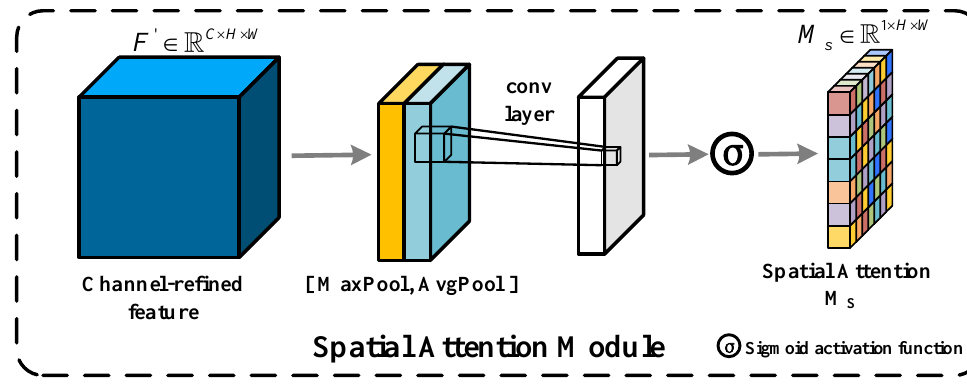
Figure 5. Architecture of SAM.